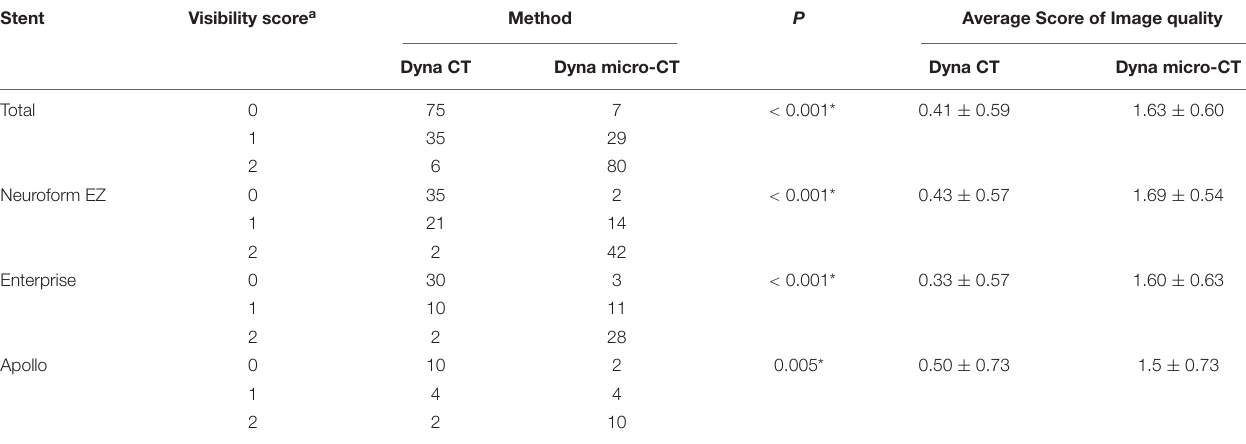
TABLE 2 | Evaluation of images obtained with FDCT and HR-FDCT (Neuroform EZ stent, n = 58; Enterprise stent, n = 42; Apollo stent, n = 16). Stent Visibility score a Method P Average Score of Image quality Dyna CT Dyna micro-CT Dyna CT Dyna micro-CT